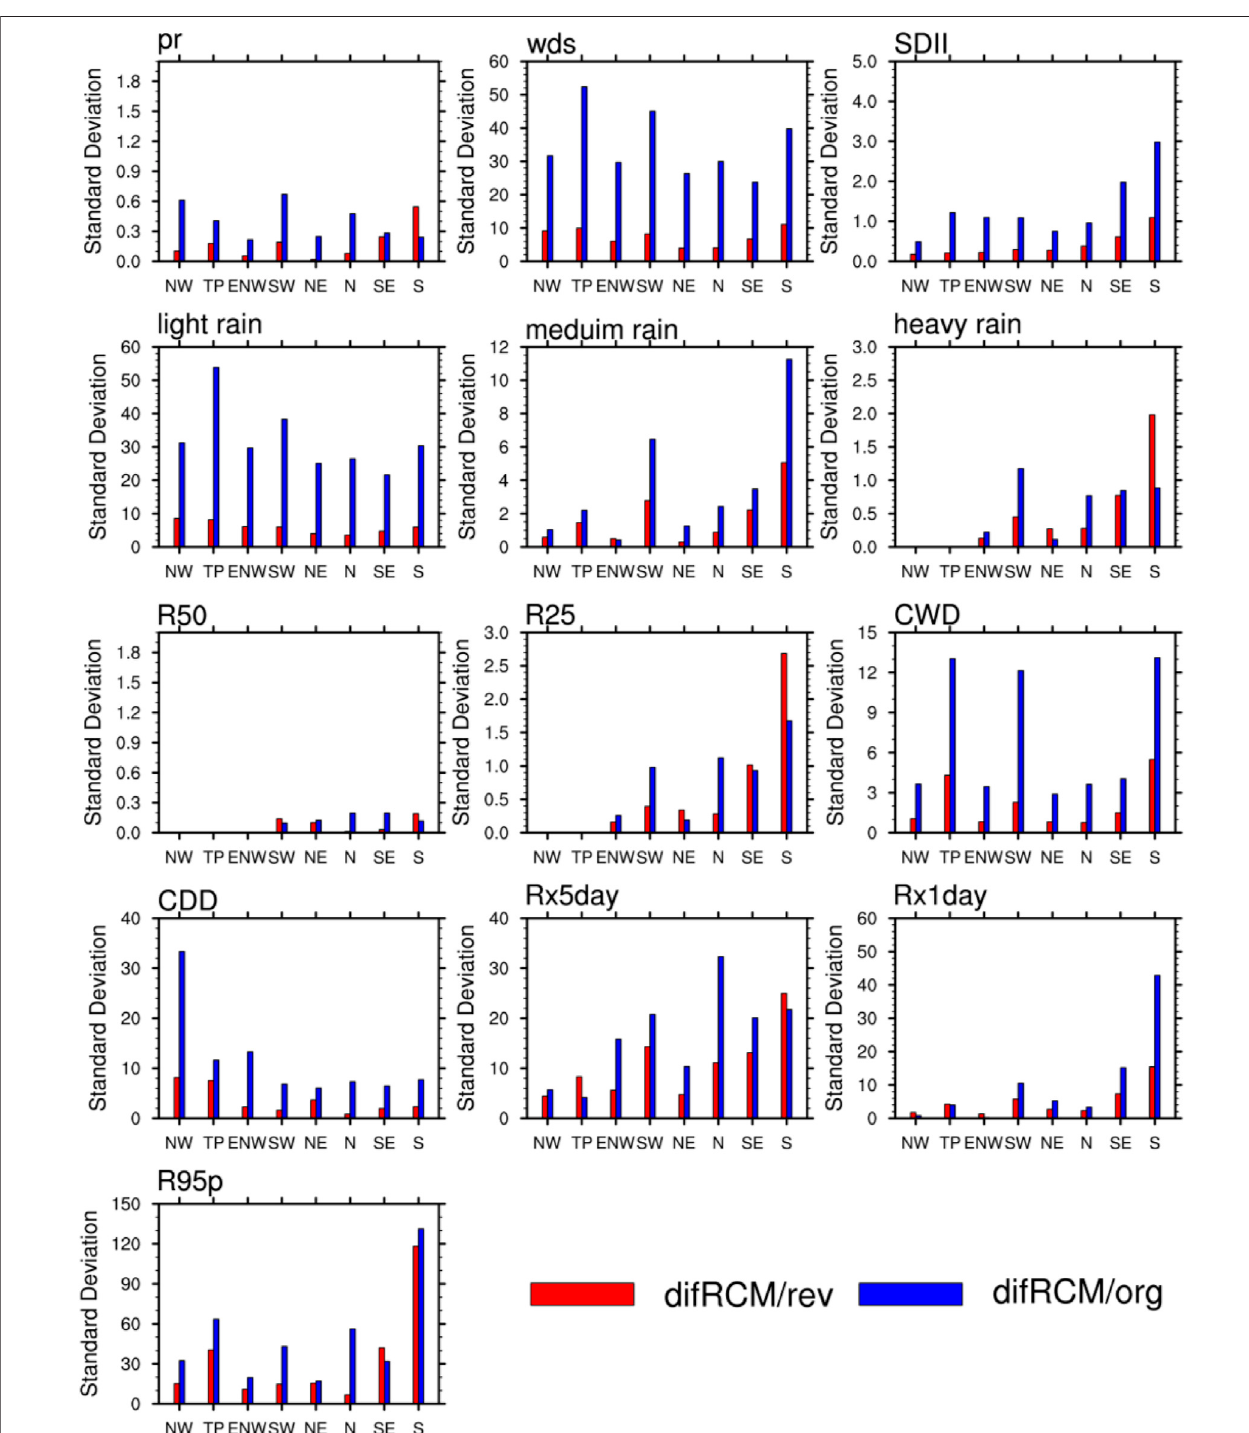
FIGURE 14 | Same as Figure 9 , but for the late 21st